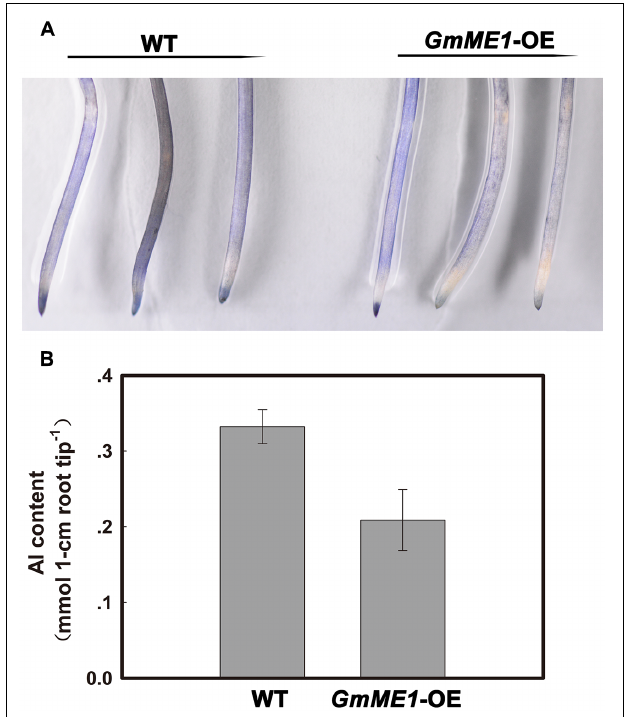
FIGURE 8 | The hematoxylin staining (A) and Al content (B) in hairy roots under Al stress. Both transgenic and WT hairy roots were exposed to 0.5 mM CaCl 2 solution (pH 4.5) with or without 30 µ M AlCl 3 . At 4 h, three Al-treated WT or transgenic hairy roots were soaked in hematoxylin solution for 30 min. Roots were rinsed by water three times before imaging with a Nikon camera (A) . Ten 0- to 1-cm root apices were excised at 4 h for Al concentration measurements (B) .